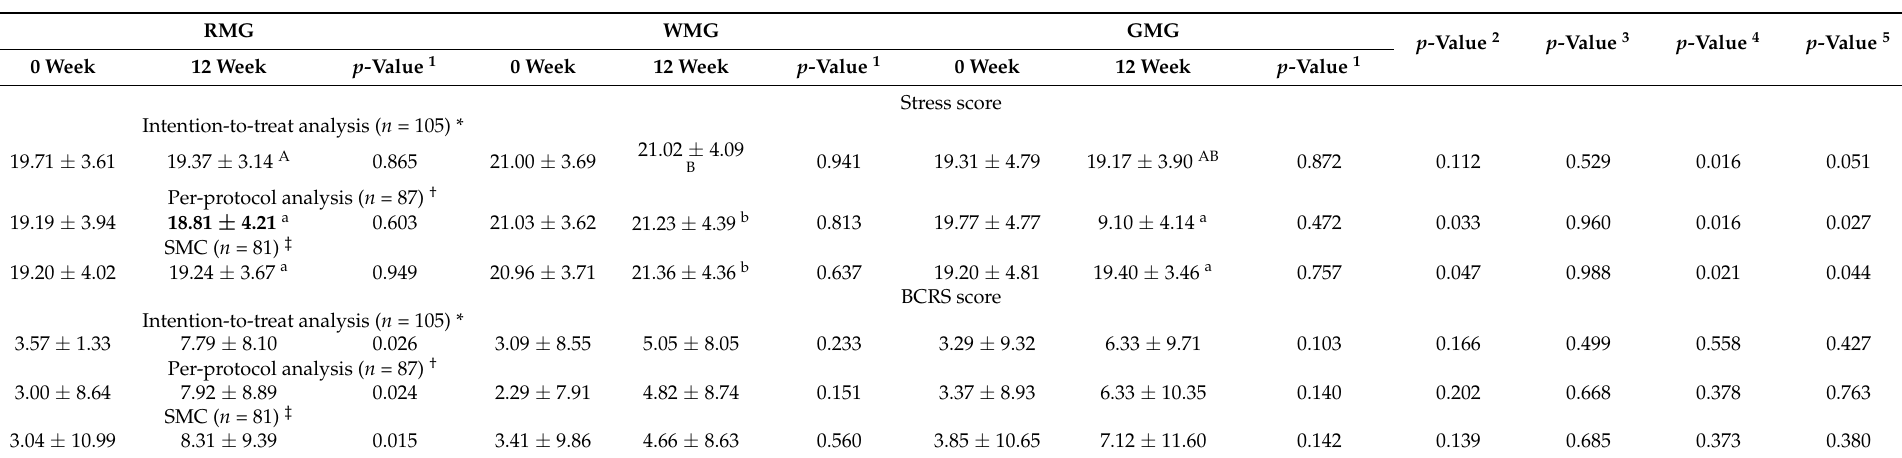
Table 4. The stress and BCRS scores of the